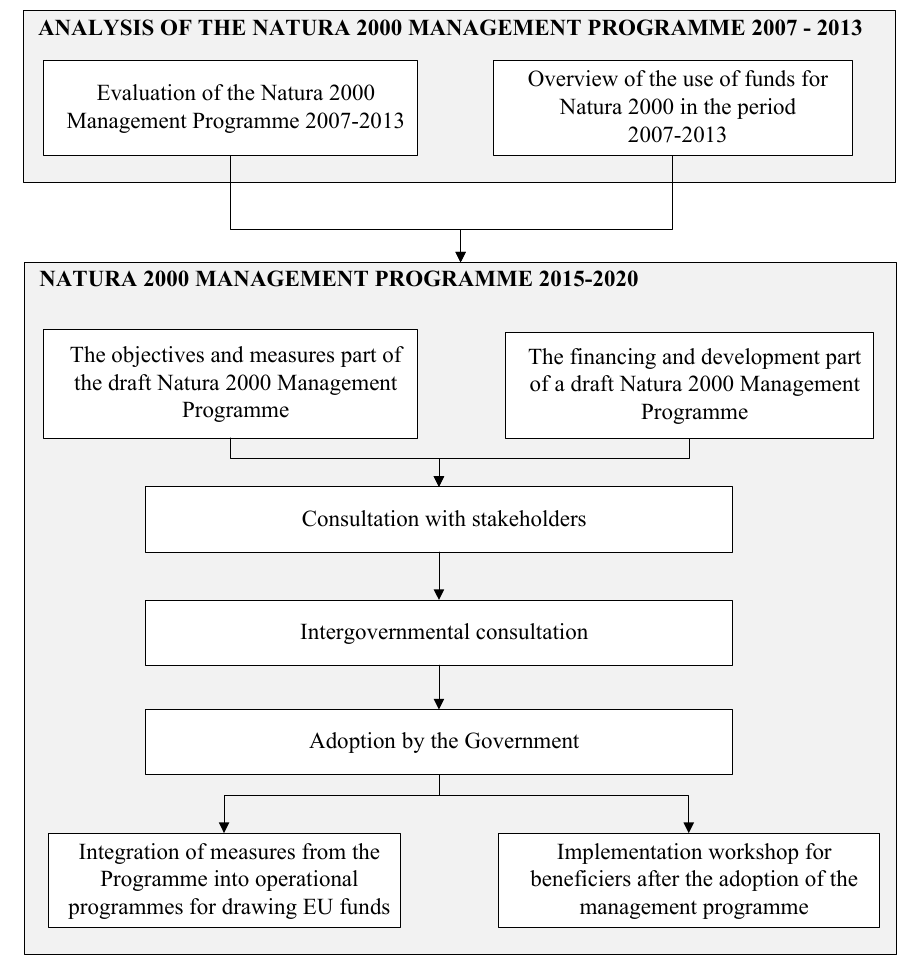
Figure 1. The formulation process of the PUN 2015–2020 in